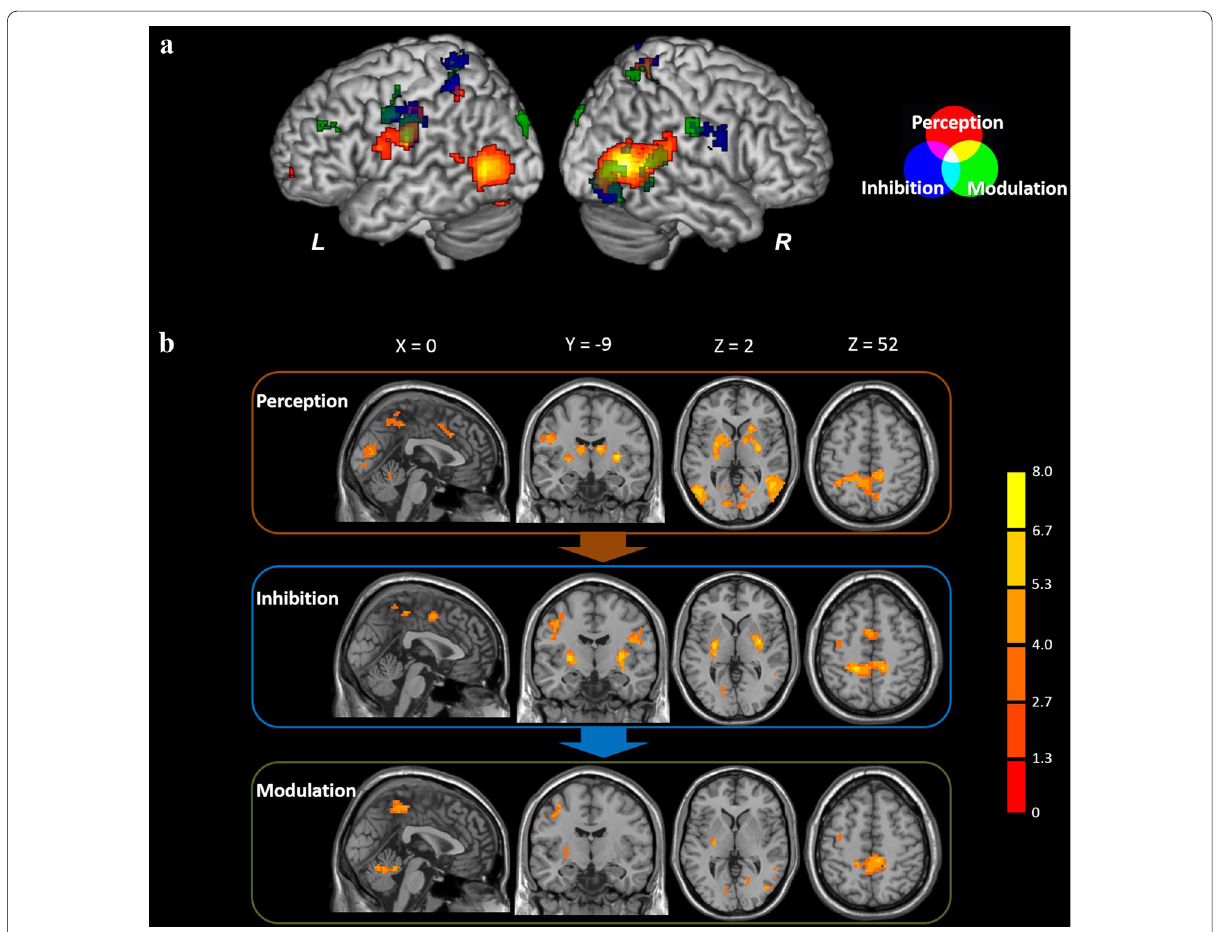
Fig. 1 Images were compared in couples between the two sessions for each stage with the paired t -tests. Increased activation was identified only in the contrast of post-test > pre-test with the threshold of p < 0.001 (uncorrected) and k > 30, revealed in MNI coordinates. The color bar indicates the t -score. a Brain activations specific to the three stages (perception, inhibition, and modulation) are overlapped and presented on the rendered human brain model. b Brain activations are shown for each stage using the three-view